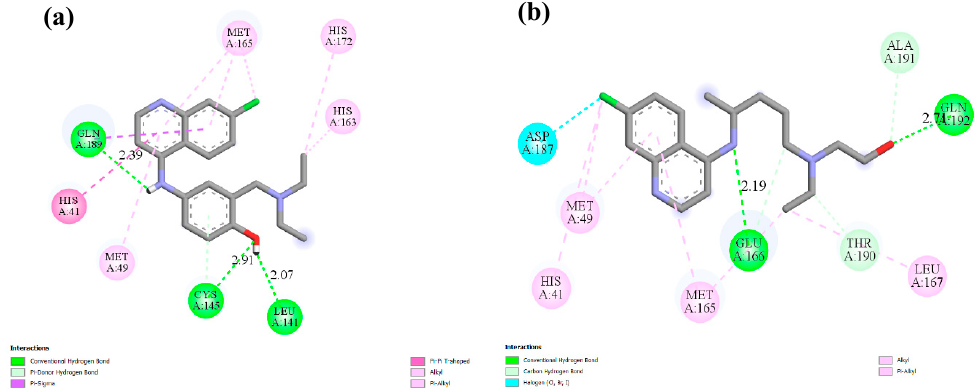
Figure 6. The interacting mode with SARS-CoV-2 M pro in 2D representations of ligand 2 ( a ), hydroxychloroquine ( b ).